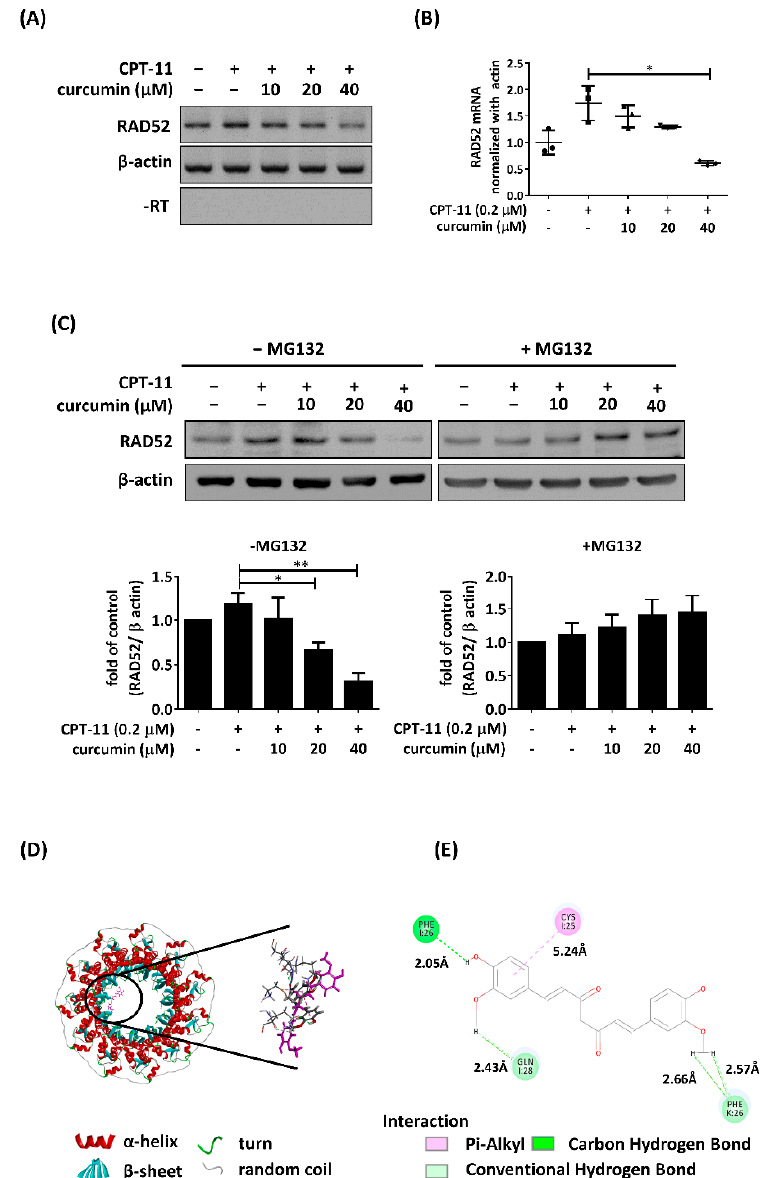
Figure 2. Curcumin translationally and post-translationally regulated RAD52 recombinase following CPT-11 treatment in MCF7 cells. ( A ) MCF7 cells were treated with 0.2 µ M CPT-11 combined with different concentrations of curcumin. After 6 h, total RNA was processed for reverse transcription to generate cDNA and analyzed with PCR and ( B ) qPCR. ( C ) MCF7 cells were cotreated with various concentrations of curcumin and 0.2 µ M CPT-11 in the presence of MG132. After 6 h, whole-cell extracts were collected for Western blot analysis. Bottom: quantification of the immunoblotting result. ( D ) A docking model of curcumin in the N-terminal domain of RAD52 shown as a ribbon (PDB ID: 1kn0). ( E ) Ligand–protein interactions with the binding residues of RAD52 and curcumin. The green dashed lines indicate hydrogen bonds, and the pink dashed lines indicate π interactions. Two-dimensional diagram showing the conventional hydrogen bond to Phe26 (2.05 Å), the carbon–hydrogen bond to Gln28 (2.43 Å) and to Phe26 (2.66 Å and 2.57 Å), and the π –alkyl interaction to Cys25 (5.24 Å). Asterisks (*) indicate significant differences between CPT-11 and combined CPT-11 and curcumin cells (* p < 0.05, ** p < 0.01).